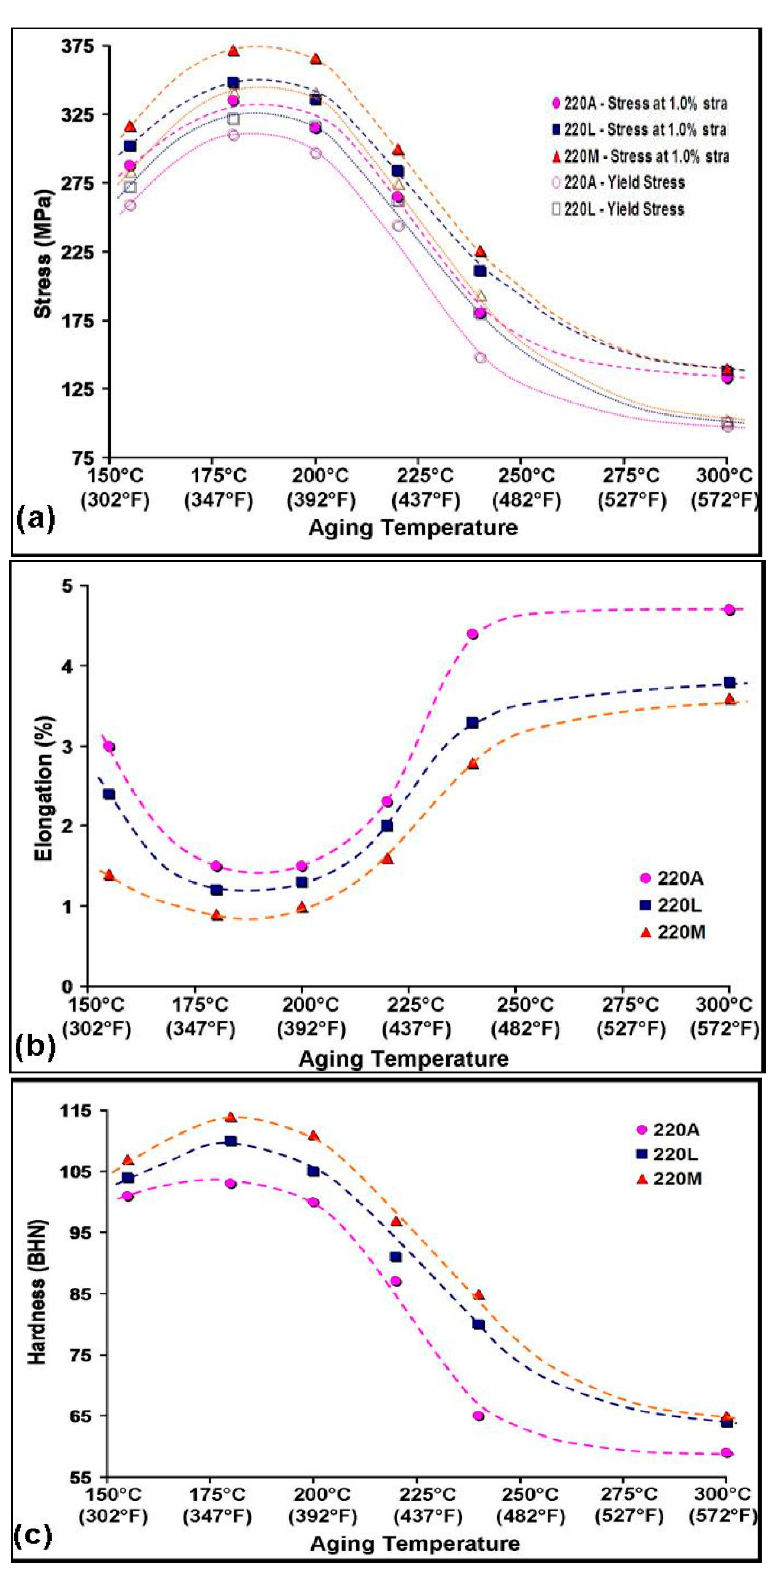
Figure 7. ( a ) Tensile stress (at 1.0% strain) and yield stress, ( b ) percent elongation, and ( c ) Brinell hardness at aging temperatures of 155 °C, 180 °C, 200 °C, 220 °C, 240 °C, and 300 °C. The Zr-containing alloys demonstrate a similar trend in hardness (Figure 7c) from 155 °C to 300 °C and converge to nearly the same value at 300 °C. On the other hand, the